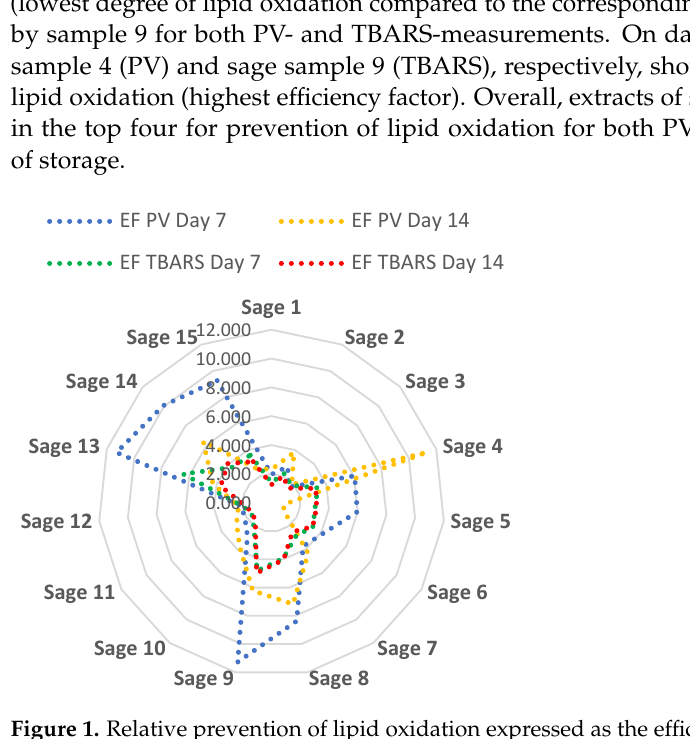
Figure 1. Relative prevention of lipid oxidation expressed as the efficiency factor (EF) for each sage extract sample at day 7 and day 14 of refrigerated storage calculated as the ability of the sage extract to inhibit lipid oxidation measured as peroxide value (PV) and thiobarbituric acid reactive substances (TBARS) in an uncured, cooked meat sample. The higher the efficiency factor, the better the ability of the sage extract to reduce lipid oxidation (PV or TBARS) in the meat sample.